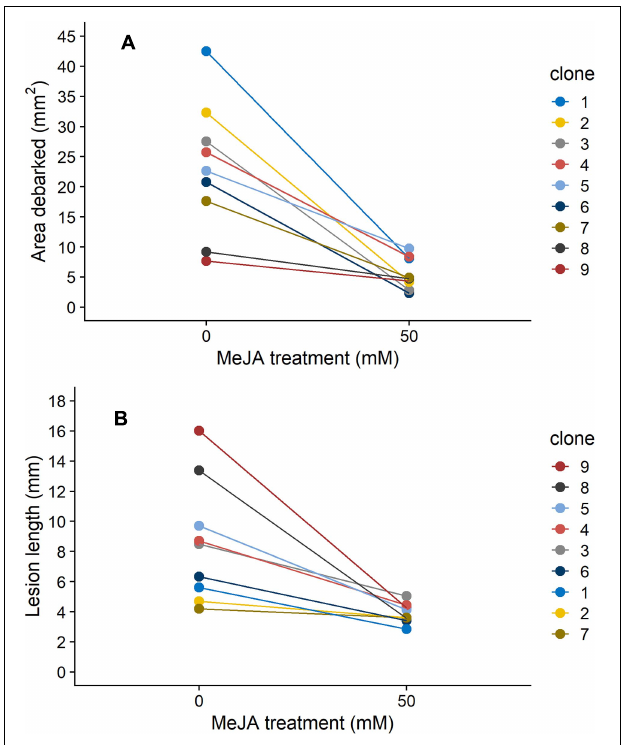
FIGURE 1 | Reaction norms depicting the change in (A) area debarked (mm 2 ) by pine weevils ( H. abietis ) and (B) lesion lengths (mm) inflicted by the blue-stain fungus ( E. polonica ) on Norway spruce ( P. abies ) clones (1–9) treated with 0 or 50 mM methyl jasmonate (MeJA). Estimated means (from models presented in Table 1 ) for each clone are shown. For clone 1, plants in the 50 mM were not included in the experiment (see section “Materials and Methods”), so results for the 25 mM MeJA treatment are presented instead. The order in which each clone’s reaction norm appears in the graph is reflected in the clone number legend for each panel. Estimates ± standard error for area debarked and lesion length, per clone and treatment combination, can be found in Supplementary Table 3